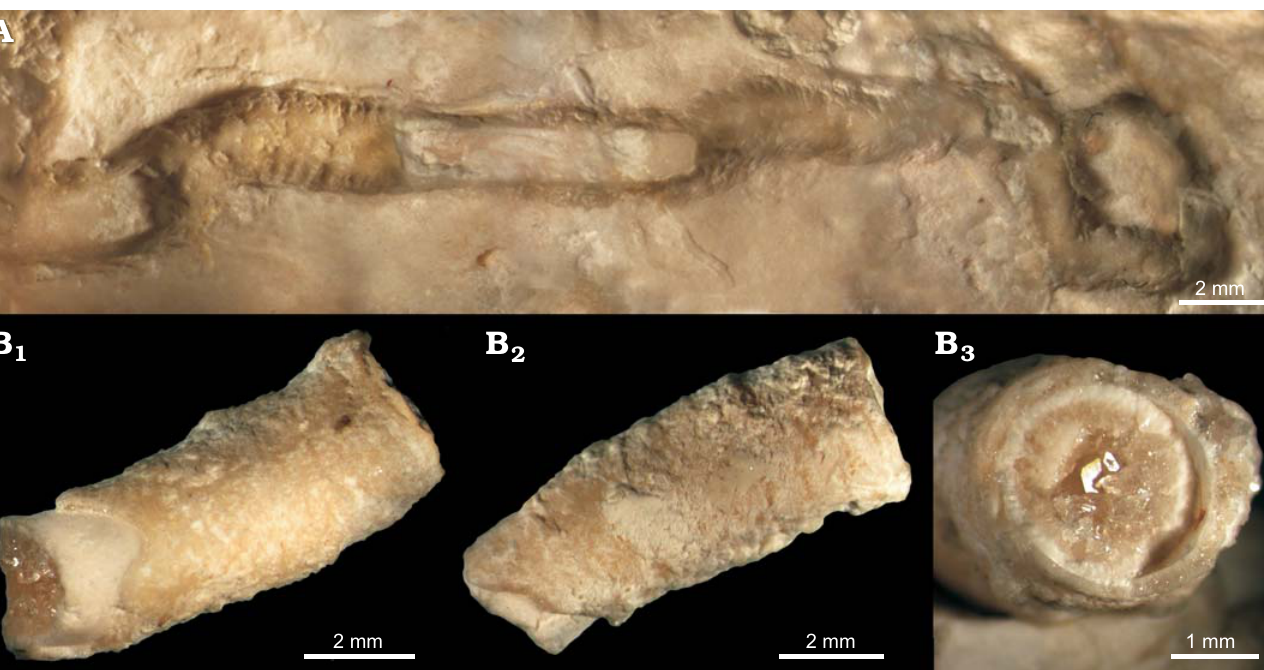
Fig. 5. Serpulid “ Serpula ” distefanoi sp. nov. from the Sosio Valley, western Sicily (Italy), Wordian to upper Permian. A . MSNC 4527, general view of the holotype. B . MSNC 4529, two opposite views (B 1 , B 2 ) of a tube fragment of the anterior erect part, showing the rough surface; cross section of the erect tube portion (B 3